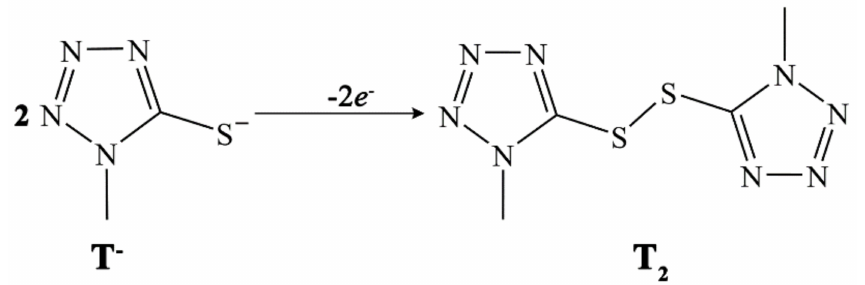
Figure 10. Molecular structures and redox equilibrium in T − /T 2 organic redox shuttle used as an alternative redox mediator by Wang and co-workers